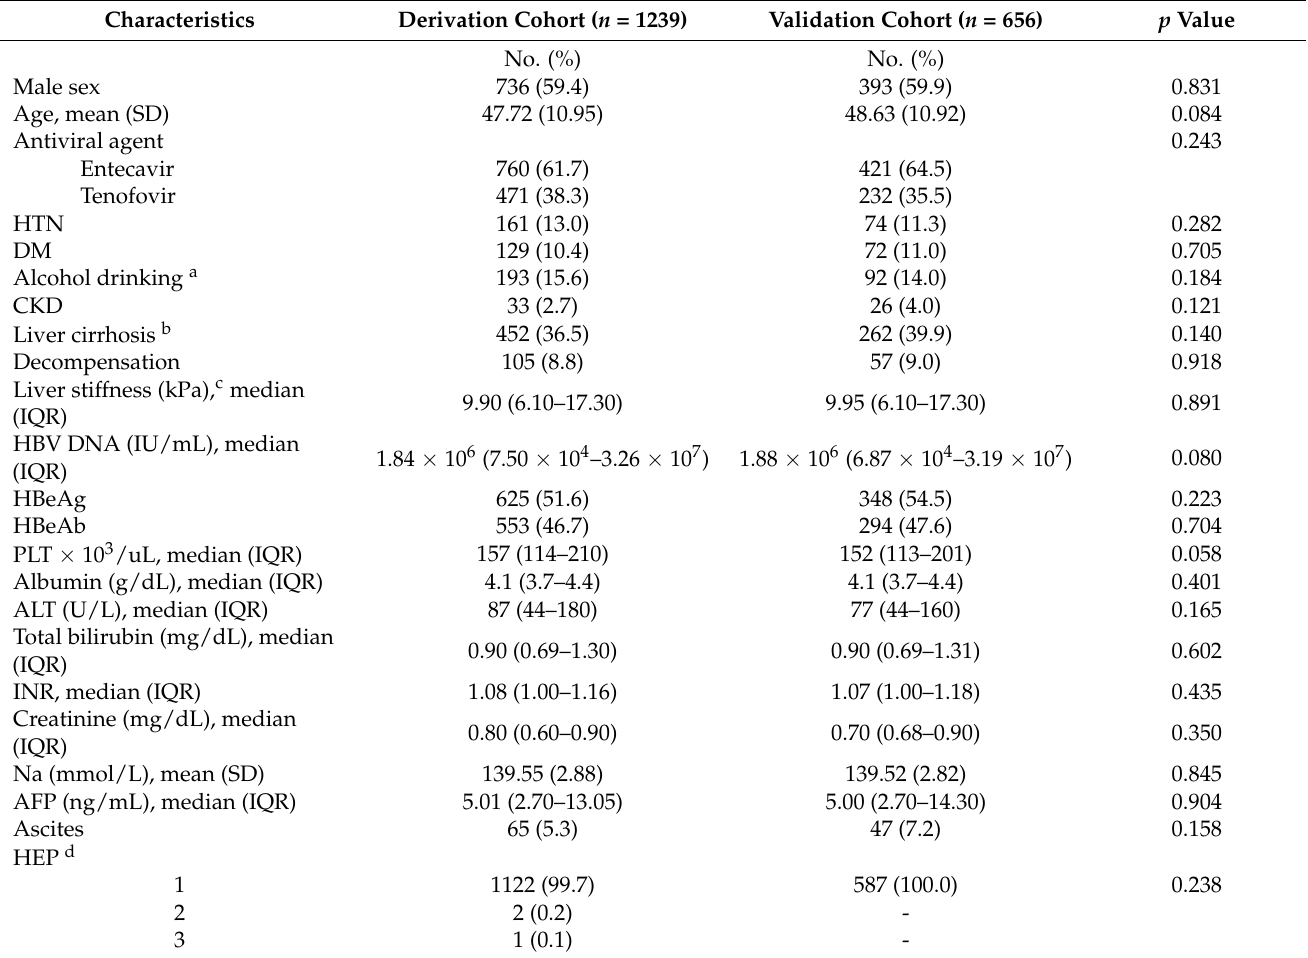
Table 1. Baseline characteristics of the derivation and validation